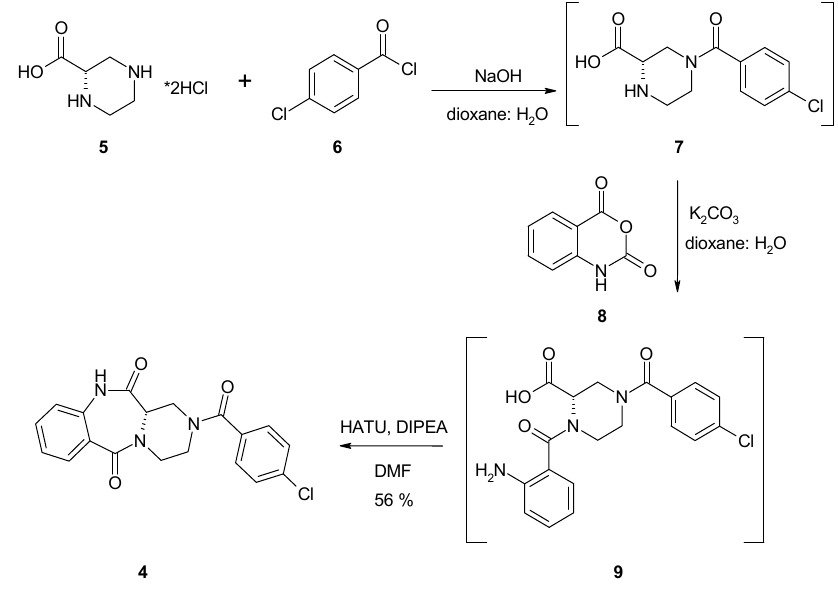
Scheme 1. Yield was added to the scheme.